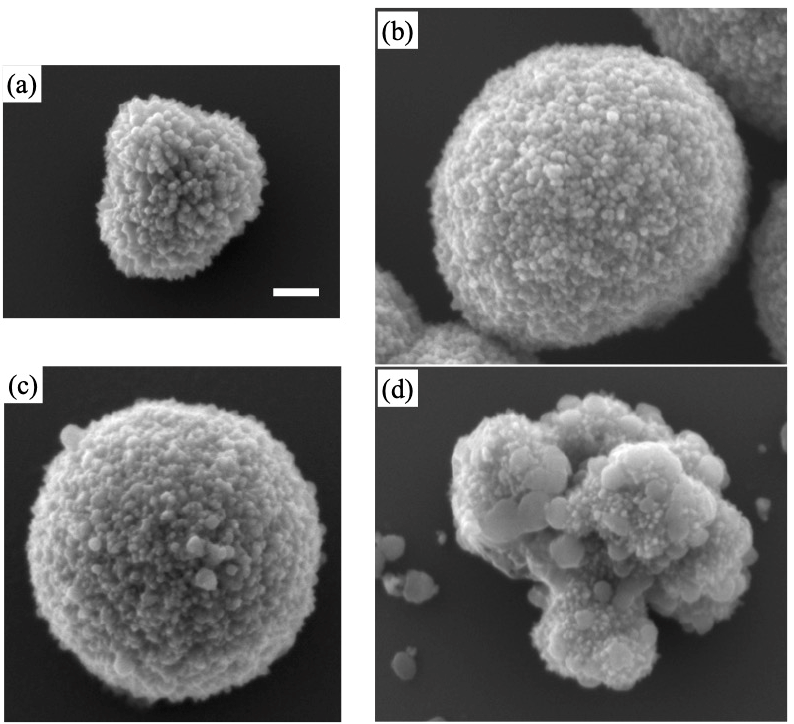
Figure 2. SEM images of ( a ) undoped and ( b , d ) Cu-doped TiO 2 particles (10 mM): ( b , c , d ) nitrate, chloride, and acetate, respectively. Scale bar indicates 200 nm.